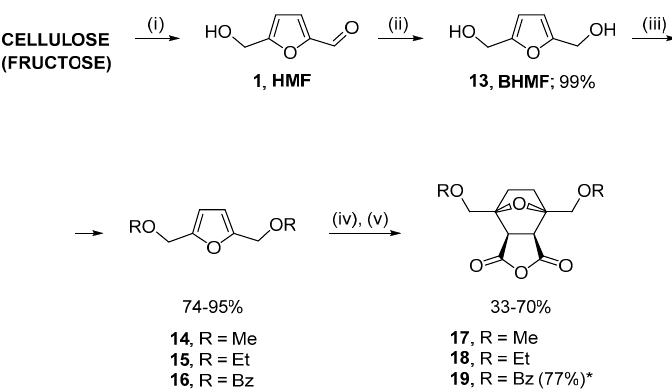
Figure 1. Increasing biological activity of cantharimide by introduction of an amino function (IC 50 in HT-29 cells is given in µM).